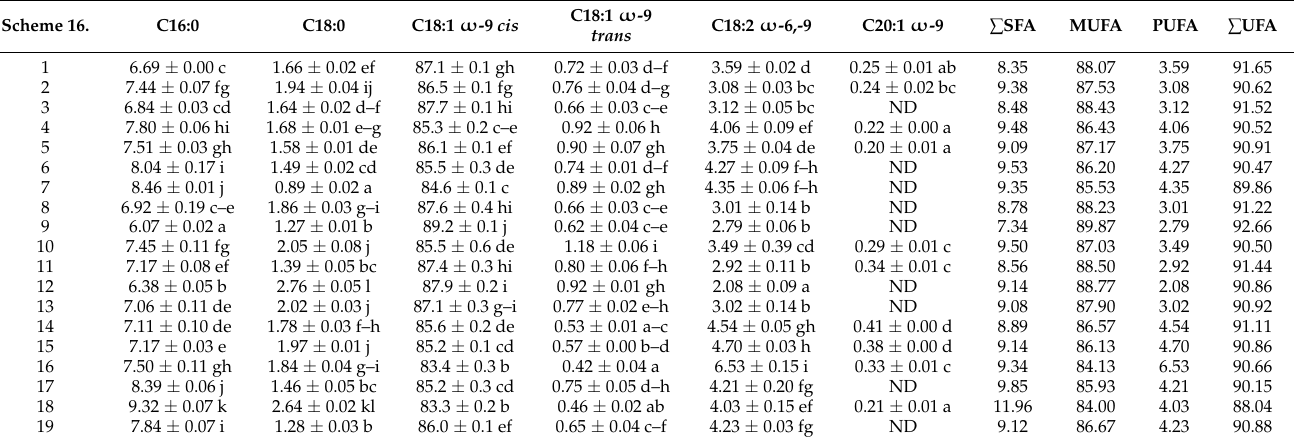
Table 3. FAs composition by GC/MS, expressed as % total fatty